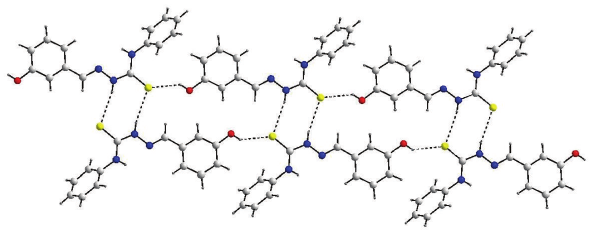
Figure 4: Double chain structure of HTSC 3 in the crystal.